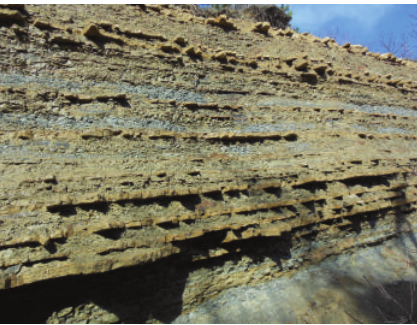
Figure 2: Vertically alternating sandstones and siltstones in the flysch rock mass at the lateral scarp of the Brus Landslide in the Istria Peninsula.